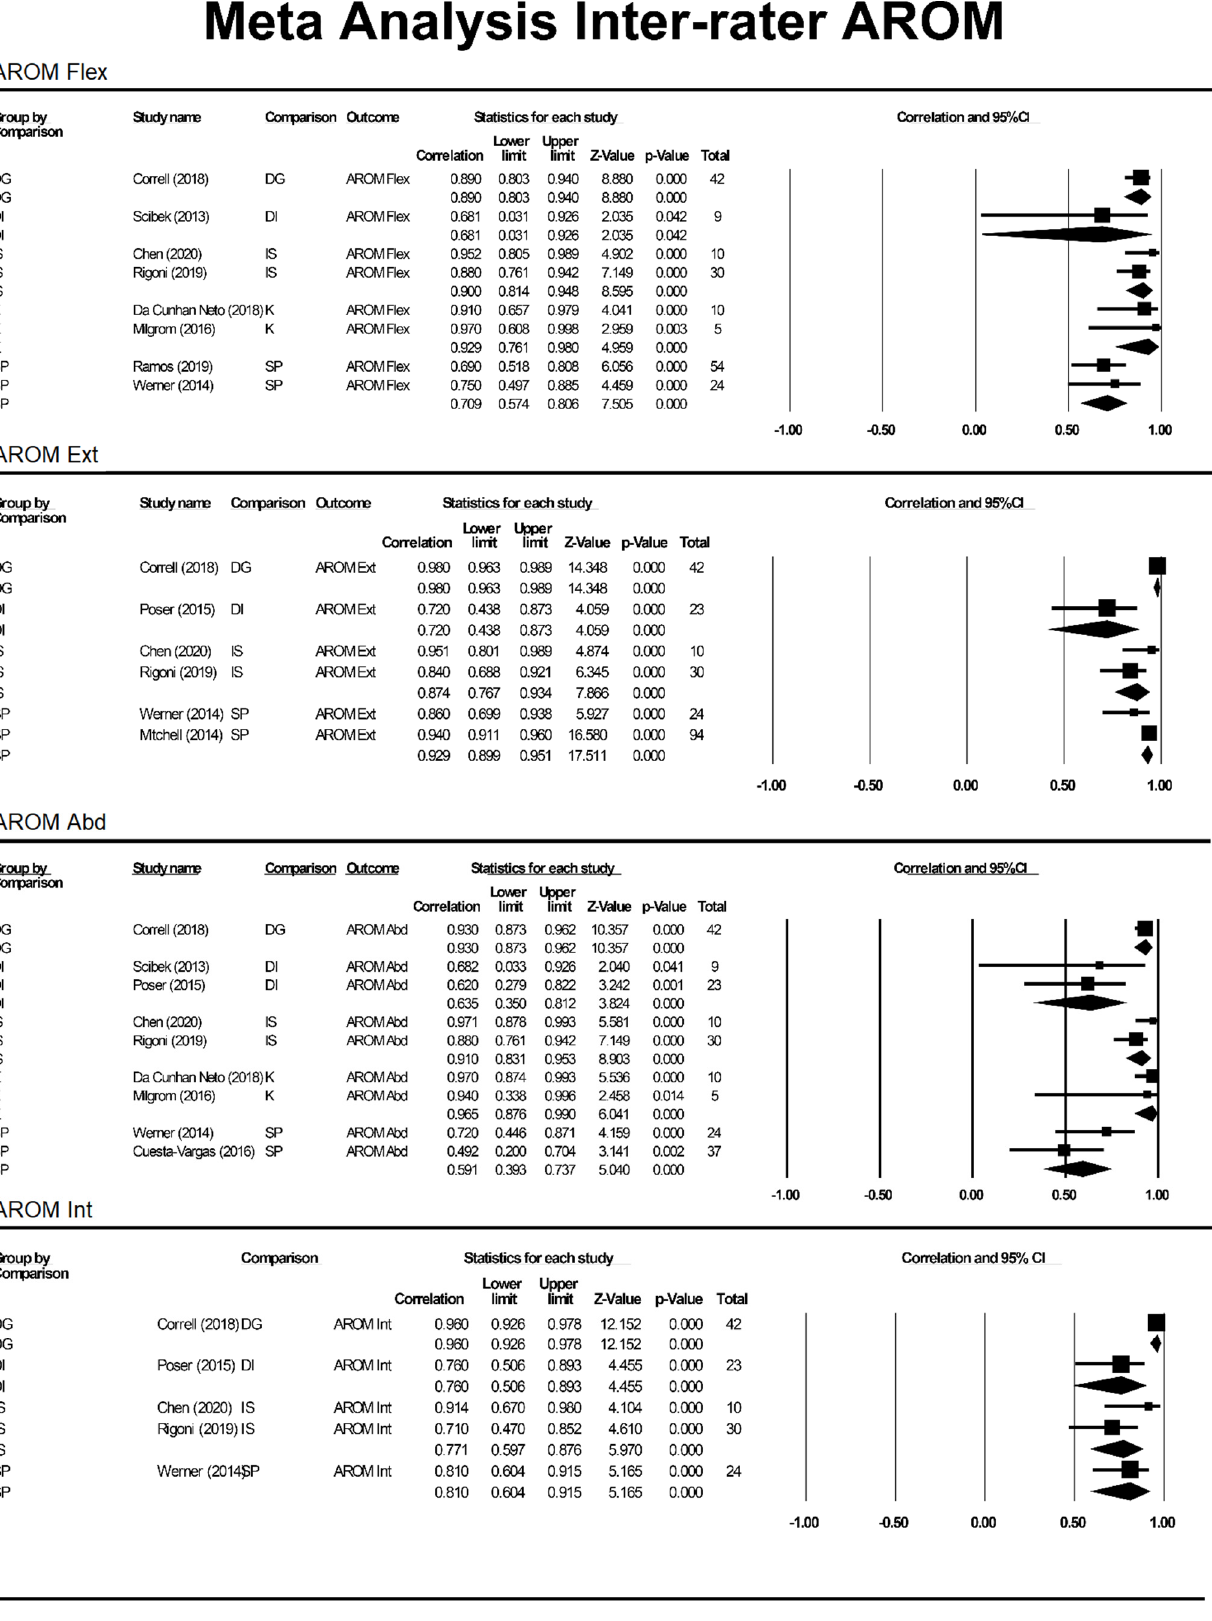
Figure 4. Meta-analysis for inter-rater aROM. DG = digital goniometer, DI = digital inclinometer, IS = inertial sensor, K = Kinect, SP = smartphone, Abd = abduction, Int = internal rotation.